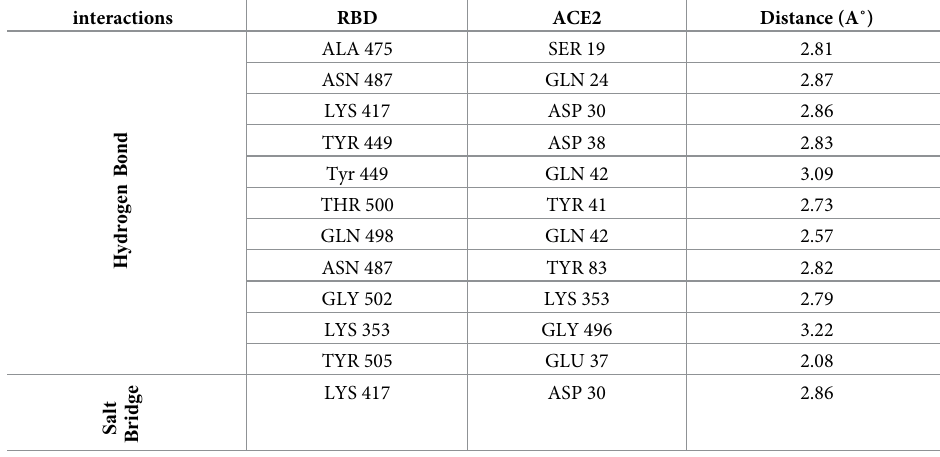
Table 1. List of interacting residues between RBD and